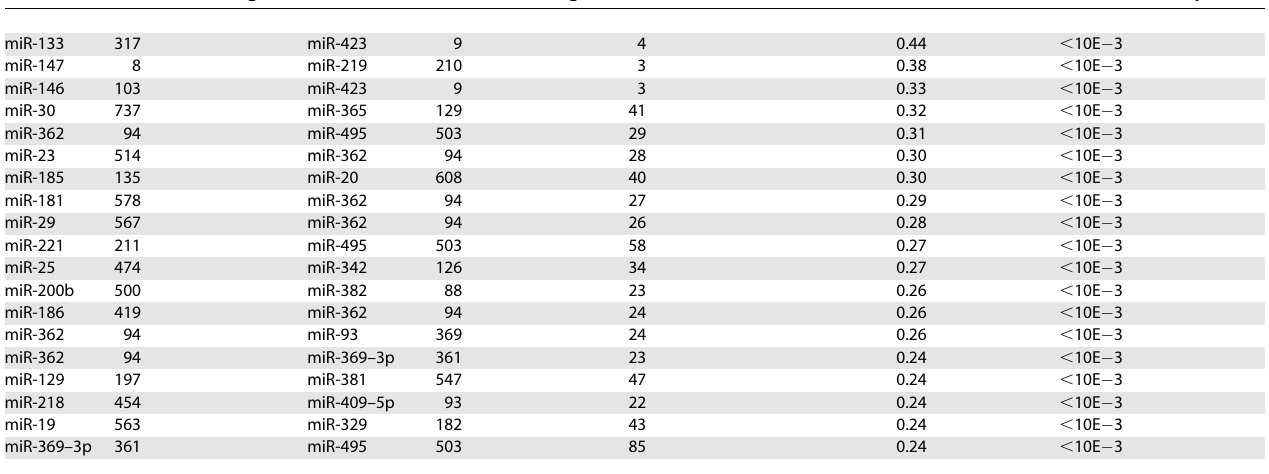
Table 2. Top 20 Most Significant Pairs of Coregulating miRNAs in the TargetScan Network First miR